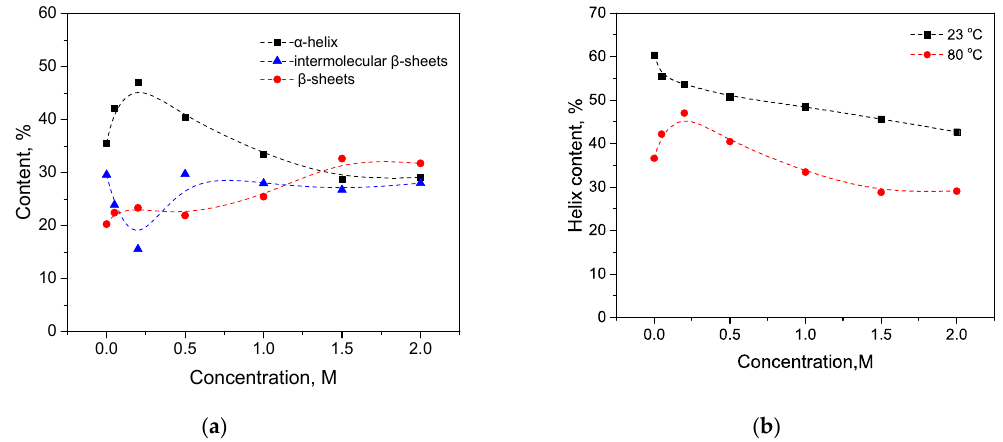
Figure 12. Change in the secondary structure of HSA in 10% wt. aqueous solution in the interaction with potassium thiocyanate at 80 °C ( a ) and α-helix content changes at 23 and 80 °C ( b ).